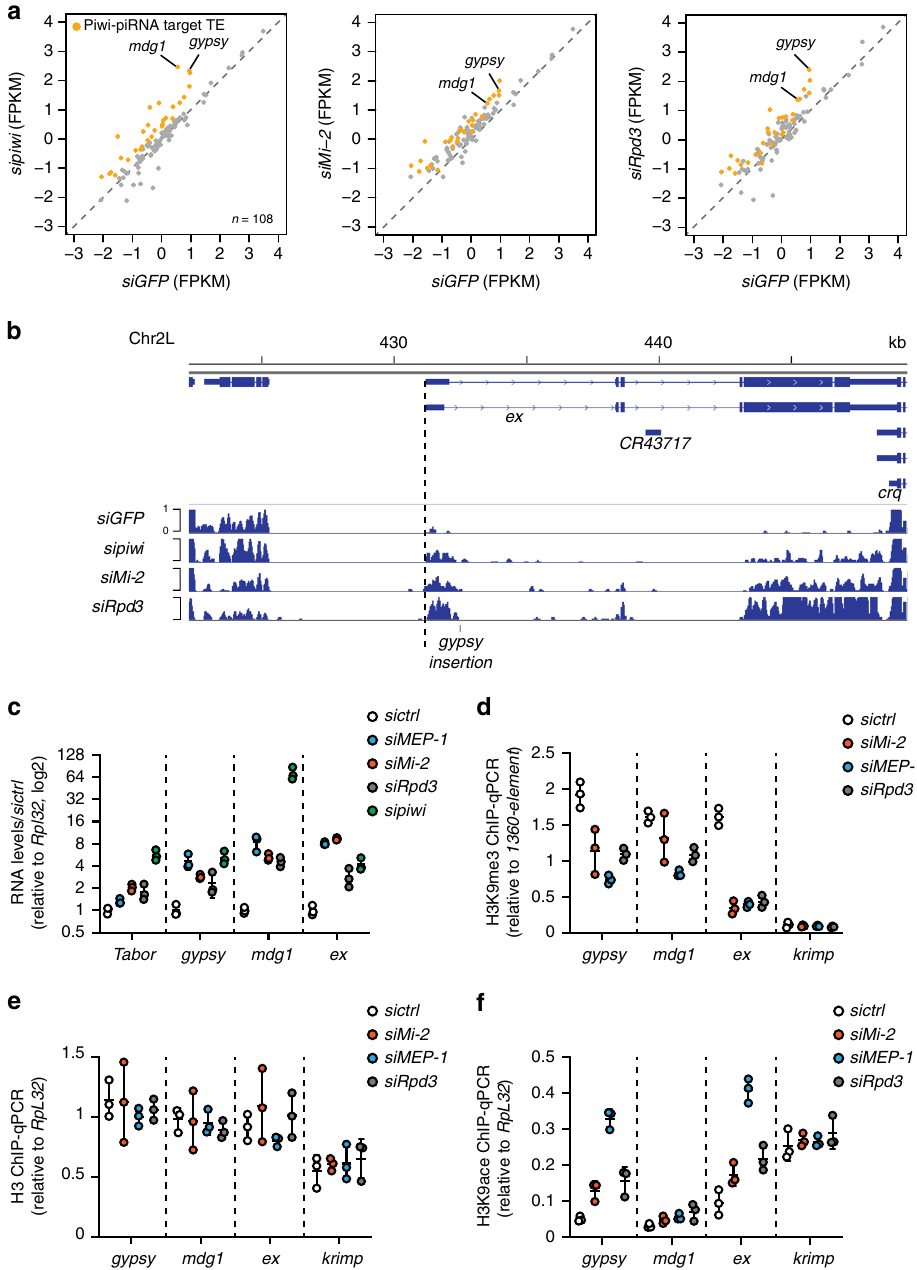
Fig. 3 Rpd3, Mi-2, and MEP-1 are implicated in TE epigenetic silencing in OSCs. a Scatterplots of RNA-seq reads in FPKM (fragments per kilobase of exon per million reads mapped) for 108 annotated D. melanogaster TEs in control knockdown (KD) ( siGFP ) vs. Piwi-KD ( sipiwi ) (left), Mi-2 KD ( siMi-2 ) (middle), and Rpd3-KD ( siRpd3 ) (right). TEs for which the expression level differed from control by more than two-fold in Piwi-KD (Piwi – piRNA-targeted TEs) are plotted in orange. Both x -axis and y -axis are a log10 scale. b A browser screenshot shows RNA-seq tracks upon GFP ( siGFP ), Piwi ( sipiwi ), Mi-2 ( siMi-2 ), and Rpd3 ( siRpd3 ) knockdown at the expanded ( ex ) locus. OSC-speci fi c Gypsy insertion site is annotated; ex TSS is indicated with a dashed line. c RT-qPCR fold changes in steady-state RNA levels of three endogenous TEs ( Tabor , Gypsy , and mdg1 ) and of the expanded ( ex ) gene upon MEP-1 ( siMEP-1 ), Mi-2 ( siMi-2 ), Rpd3 ( siRpd3 ), or Piwi ( sipiwi ) knockdown using siRNAs. Dots show RNA values quanti fi ed relative to Rpl32 and normalized to control knockdown for n = 3 biologically independent samples, lines represent mean values ± SD (log2). d – f H3K9me3 ( d ), H3 ( e ), or H3K9ace ( f ) quanti fi ed by ChIP-qPCR at mdg1 and Gypsy TE genomic loci, as well as on the expanded ( ex ) and krimper ( krimp ) genes after knockdown using the indicated siRNA. Values relative to a positive control ( 1360-element for H3K9me3 or RpL32 for H3 and H3K9ace) were normalized to input (mean ± SD from n = 3 independent biological replicates). Source data for c – f : Supplementary Data set RT-qPCR in total ovarian extracts (Fig. 4c). After RNAi against effects of Rpd3 depletion in vivo and ex vivo could be due to a Rpd3, the LacZ expression was irregular from one ovariole to possible low ef fi ciency of the RNAi in fl ies. In summary, a another, from weak to null, preventing us from concluding on the functional role in TE repression was demonstrated ex vivo for effect of Rpd3 depletion in vivo. The discrepancy between the Rpd3 and both ex vivo and in vivo for Mi-2 and MEP-1.